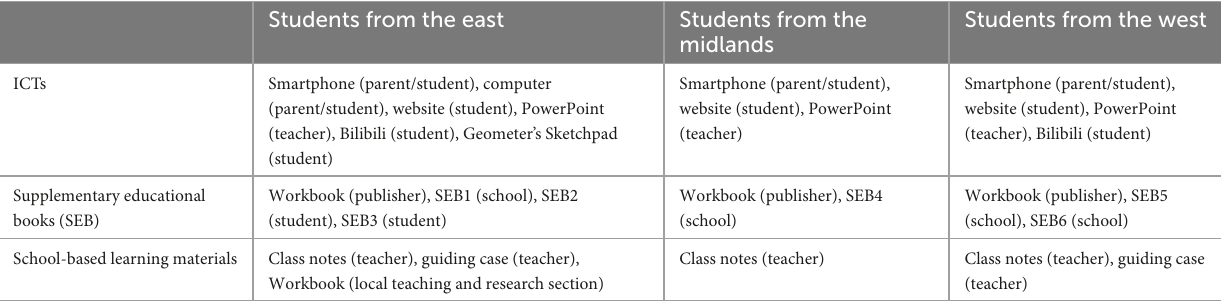
TABLE 6 The classifications of other curriculum resources and their deciders. Students from the east Students from the